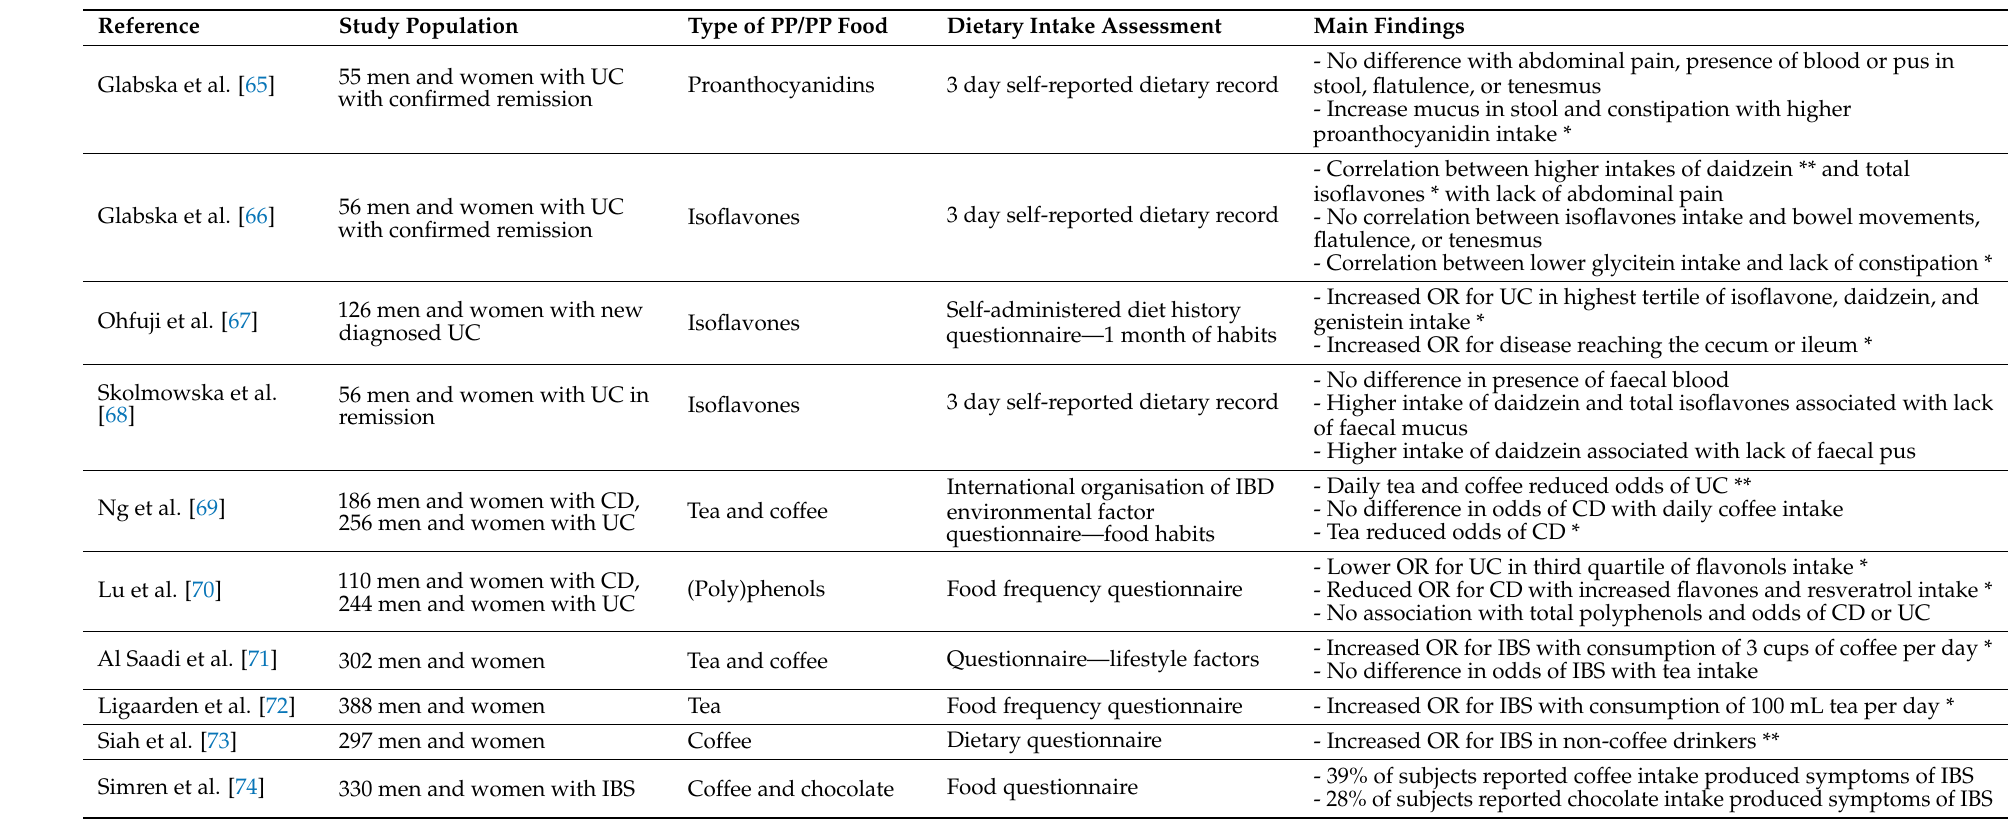
Table 4. Summary of observational studies of (poly)phenols in inflammatory bowel disease (IBD) and irritable bowel syndrome